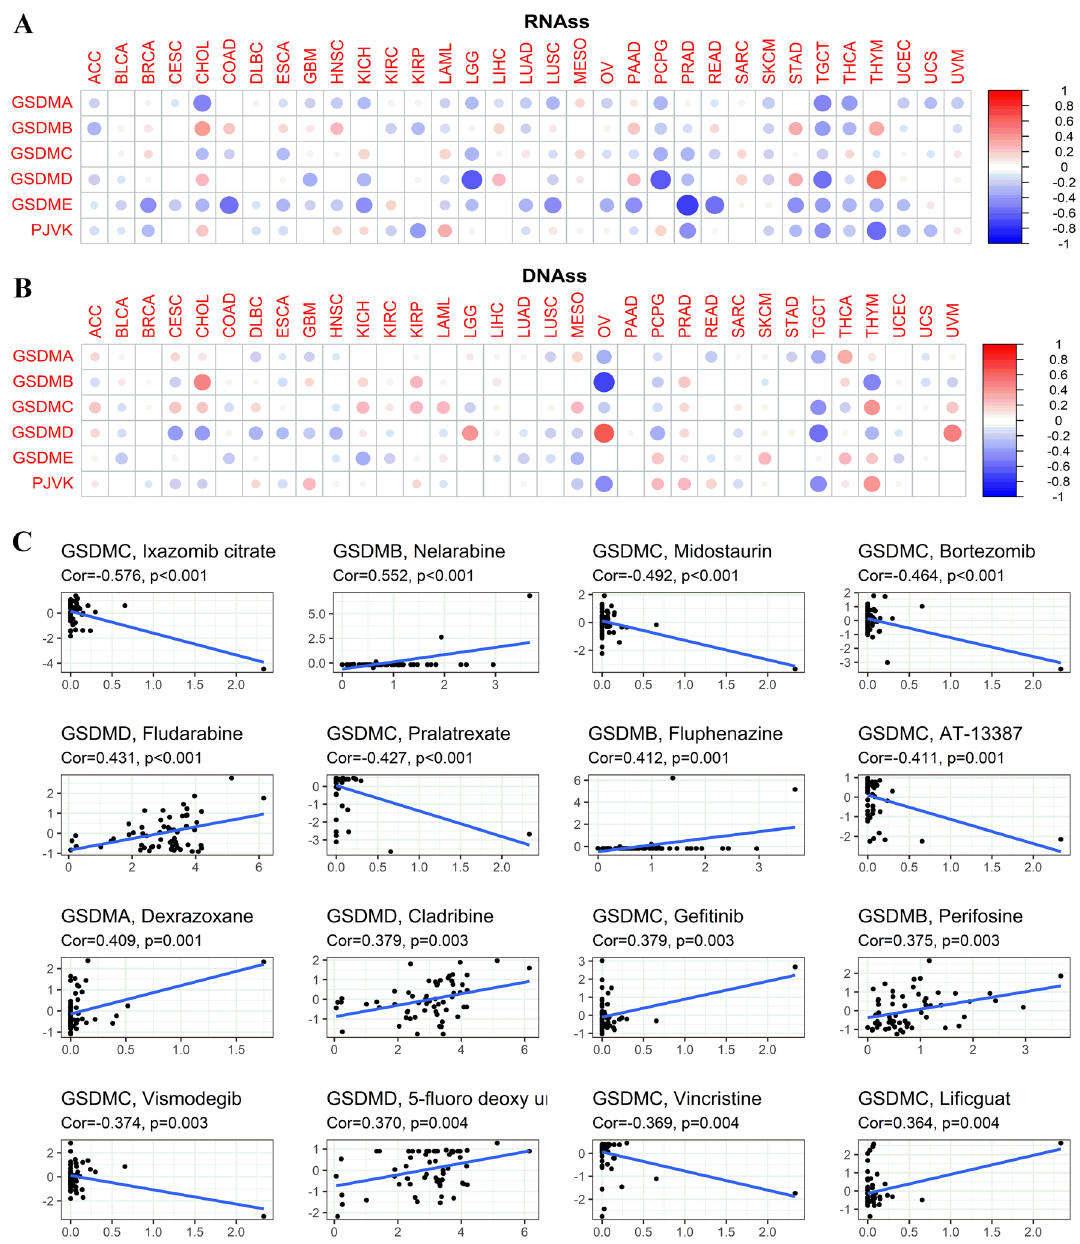
Figure 10. Correlations of gasdermin family gene expression with tumor stemness and treatment susceptibility. The associations between gasdermin family gene expression with tumor stemness scores, including RNAss ( A ) and DNAss ( B ); The size of the dots represented the absolute value of the correlation coefficients; The bigger the size is, the stronger the correlation would be; The red and blue represented the positive or negative correlation, respectively. Spearman’s correlation showing the associations between gasdermin family gene expression and drug sensitivity using NCI-60 cell line data ( C